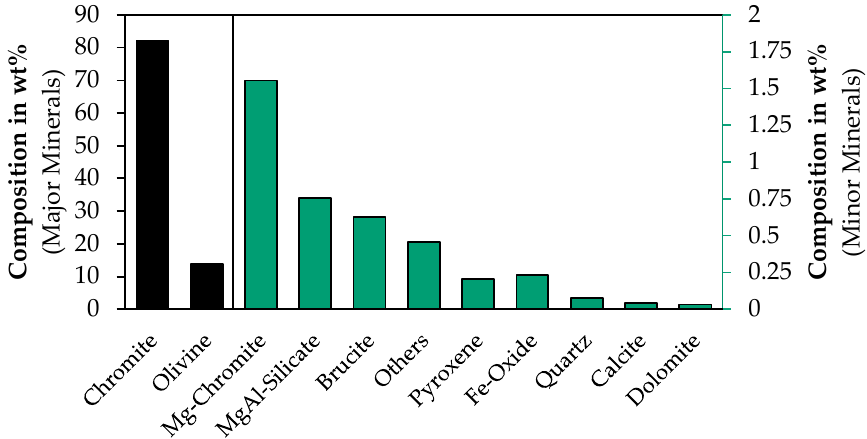
Figure 5. Mineralogical composition as determined by QEMSCAN ® .